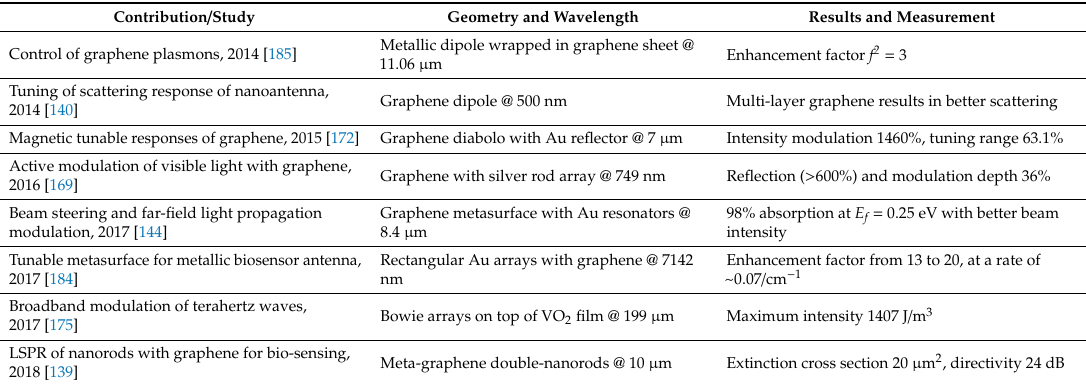
Table 2. Summary of graphene–metal antennas and their contributions as discussed in Section 4. LSPR: localized surface plasmon